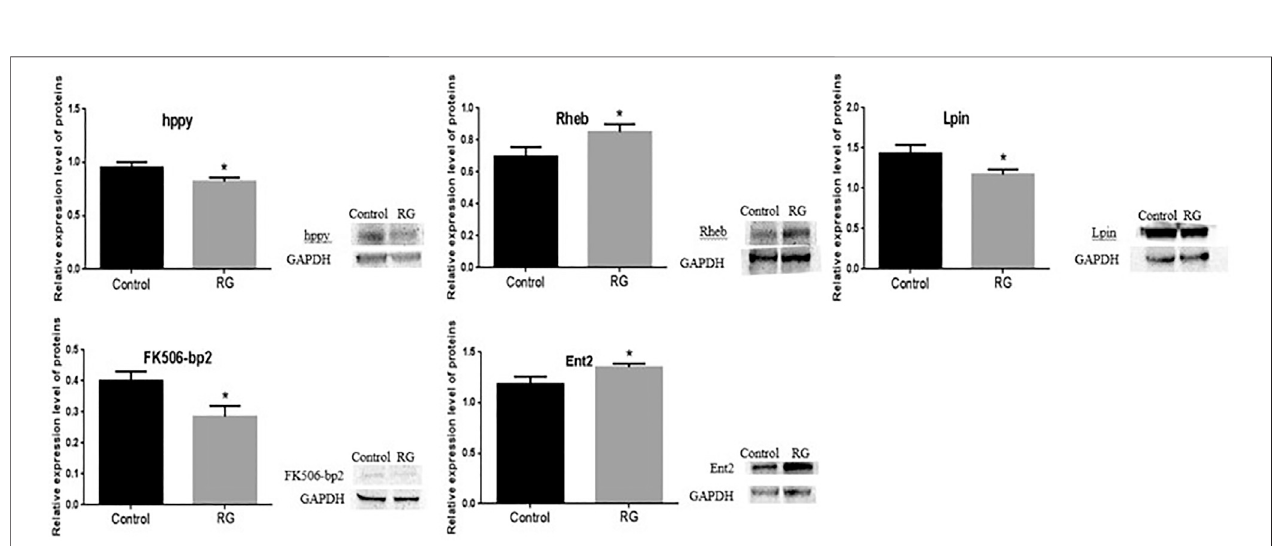
FIGURE 6 | Expression of hppy, Rheb, Lpin, FK506-bp2 and Ent2 were con fi rmed using western blotting. P value < 0.05 was considered statistically signi fi cant.; Abbreviation: RG, red ginseng.